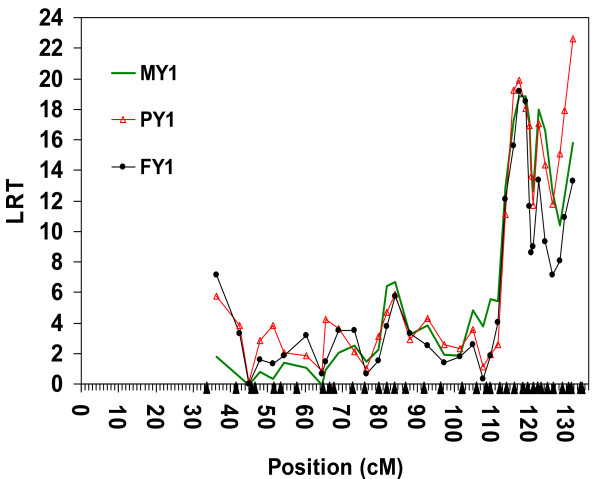
LDL analysis by variance component approach using microsatellites in a complex pedigree of 2089 animals. Joint linkage disequilibrium and linkage (LDL) analysis for three milk yield traits; Milk Yield (MY1), Milk Protein Yield (PY1) and Milk Fat Yield (FY1) during first lactation using 37 microsatellites, a complex pedigree of 2 089 animals, EBV as phenotype and AIREML as implemented in LDLRAMS and LDL program. Chromosome length in centiMorgan (cM) on the X-axis, log-likelihood ratio test (LRT) values on the Y-axis. Solid triangles on the X-axis represent positions of markers included in the analysis.